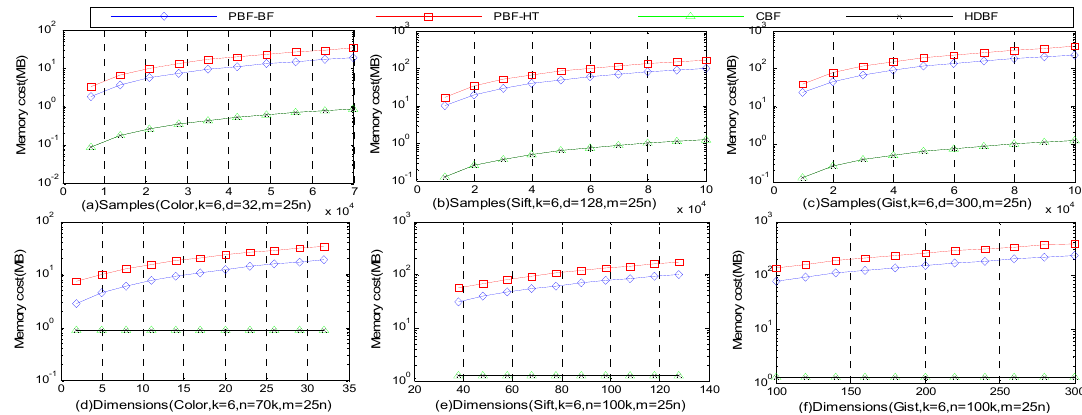
Figure 8. Memory usages of the PBF-BF, PBF-HT, CBF and HDBF with a fixed FPP.